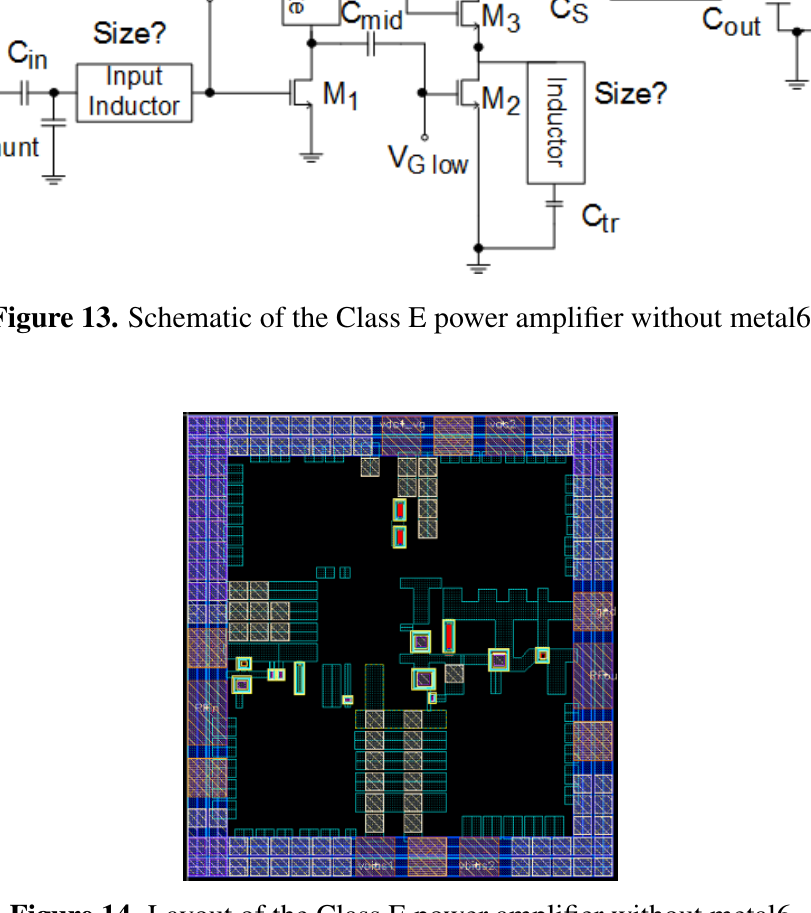
Figure 14. Layout of the Class E power amplifier without